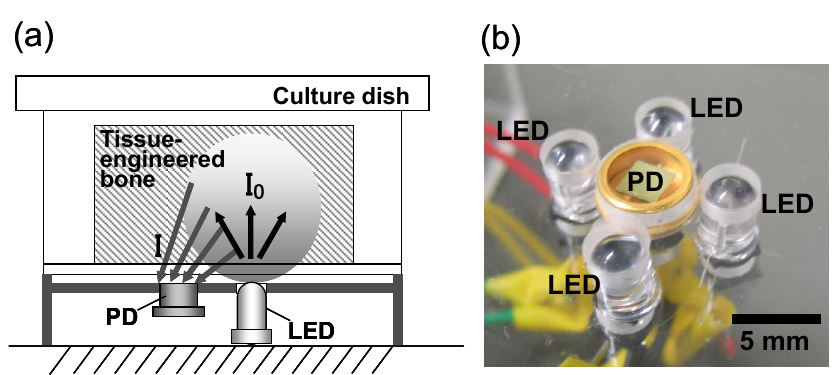
Fig. 1 Optical monitoring system for the calcification of tissue-engineered bone. (a) Tissue-engineered bone on a culture dish is irradiated with near-infrared light (850 nm) . Diffuse reflective light from the bone is detected by a PD at from LEDs at an intensity of I 0 an intensity of I. (b) Optical sensing unit composed of four LEDs and one PD.